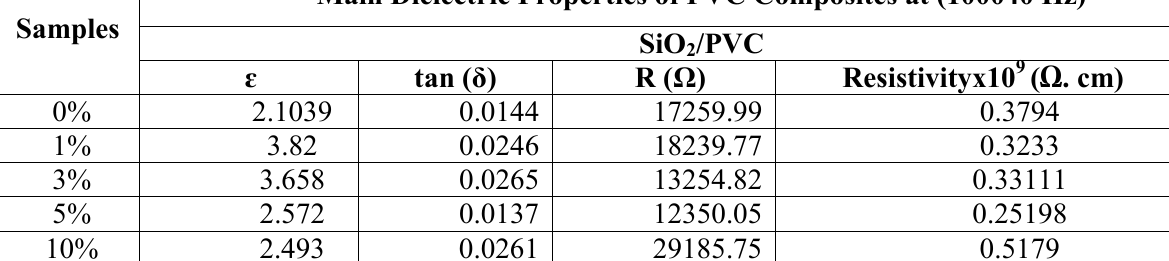
Table 5: Dielectric properties of PVC composite films.